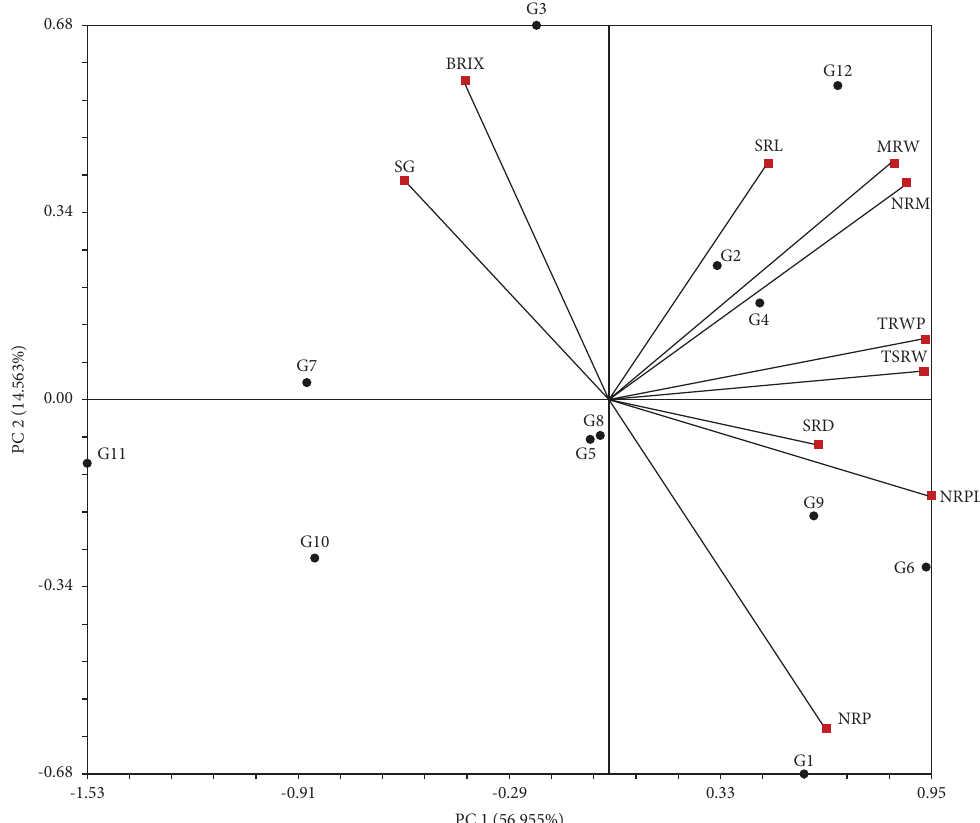
Figure 3: Distribution pattern of nine genotypes PFSP and three commercial varieties as checks based on ten agronomic traits in